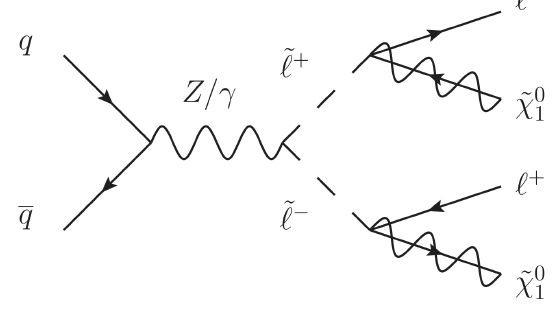
Figure 5 . Pair production and decay of sleptons at hadron colliders. ˜ ‘ represents a charged slepton and ˜ χ 0 the lightest 1